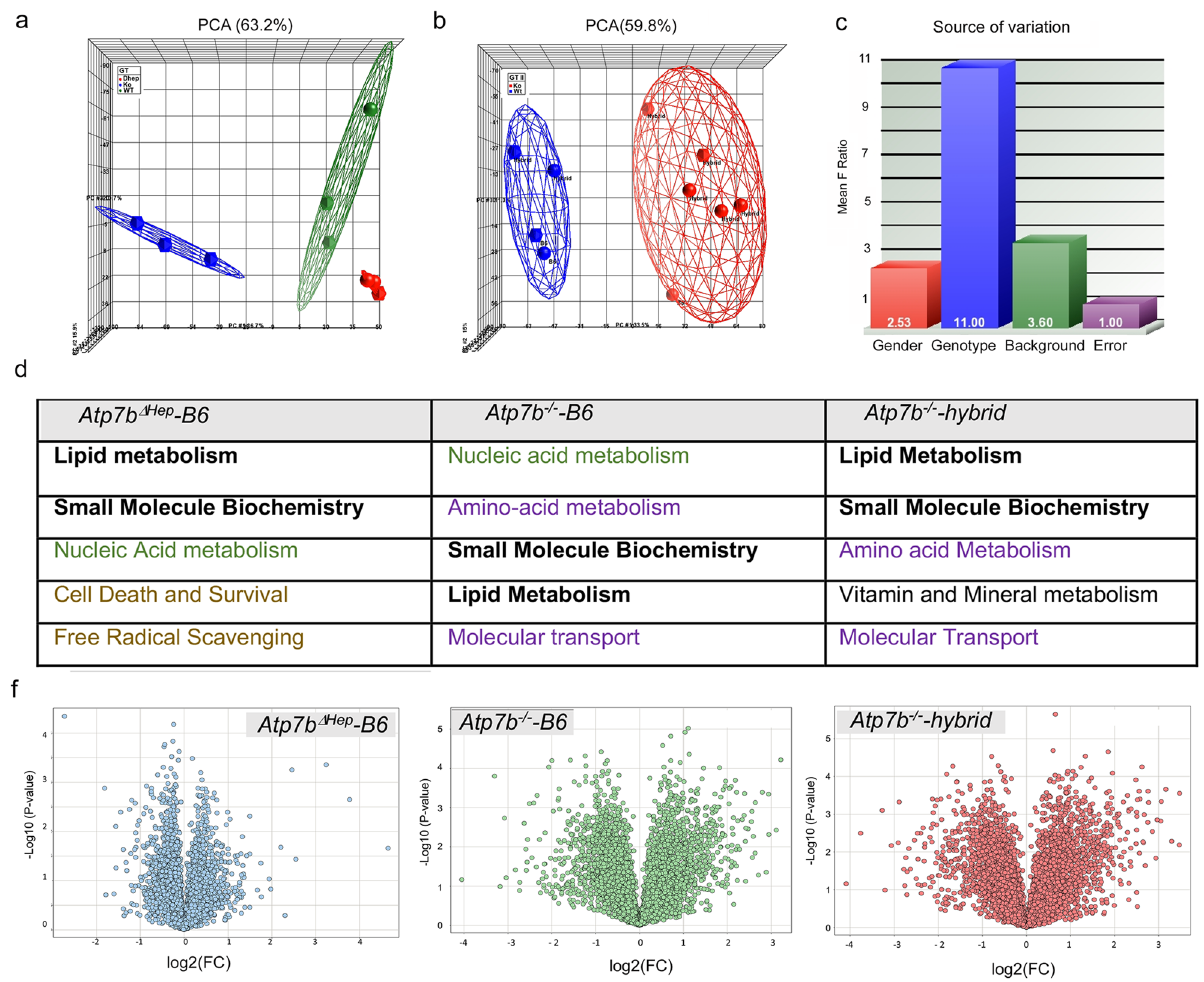
Figure 6. Changes in proteomes reflect the functional state of liver tissue. ( a ) The PCA plot illustrates complete segregation of WT-B6 (green), Atp7b ΔHep - B6 (red), and Atp7b -/– B6 (blue) protein profiles. ( b ) The PCA of protein profiles from Atp7b -/– hybrid and Atp7b -/– B6 livers and the respective backgrounds controls demonstrate differences between the WT (blue) proteomes and Atp7b − / − proteomes (red) that are independent of strain background. ( c ) Variance analysis identifies the Atp7b status (genotype) as the major contributor to changes in the liver proteomes along with gender and genetic background as minor contributors. ( d, top ) The most significantly affected cellular functions in each Atp7b mutant strains identified by the Ingenuity pathway analysis (https ://digit alins ights .qiage n.com/produ cts-overv iew/disco very-insig hts-portf olio/analy sis-and-visua lizat ion/ qiage n-ipa/). The cellular functions altered in all mutant strains are shown in bold; the processes affected in both global knockouts are in purple; pathways more strongly upregulated in the hepatocyte-specific knockout (compared to the background-matched global knockout) are in light brown. Nucleic acid metabolism (green) is strongly dis-regulated in both global and hepatocyte-specific knockouts when compared in the same mass- spectrometry run ( d, bottom ) The corresponding volcano plots depicting protein changes in each Atp7b mutant liver in comparison to the respective background matched control (The data were visualized using Spotfire DecisionSite with Functional Genomics